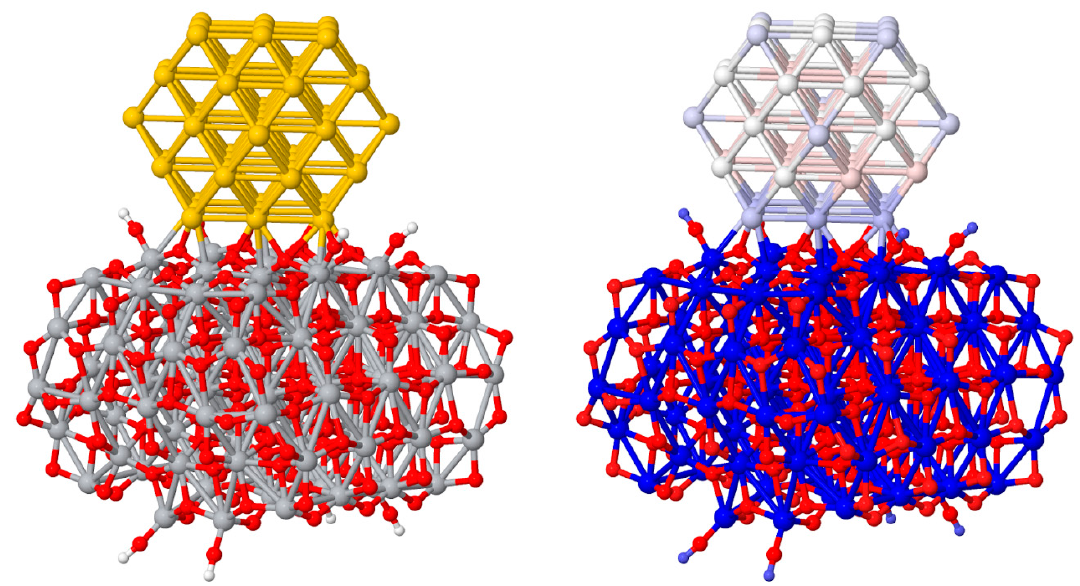
Figure 7. The (Au 55 (TiO 2 ) 97 H 8 ) + 5 with standard atom coloring (left) with color-rendered atomic charges (right), so that red represents negatively charged atoms, blue positively charged atoms, and white neutral atoms.